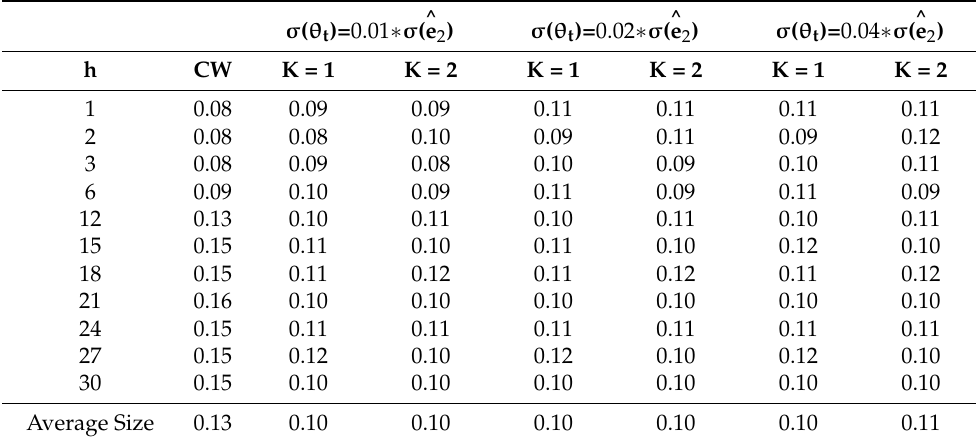
Table 3. Empirical size comparisons between CW and WCW tests with nominal size of 10%, consid- ering DGP2 and a large sample.